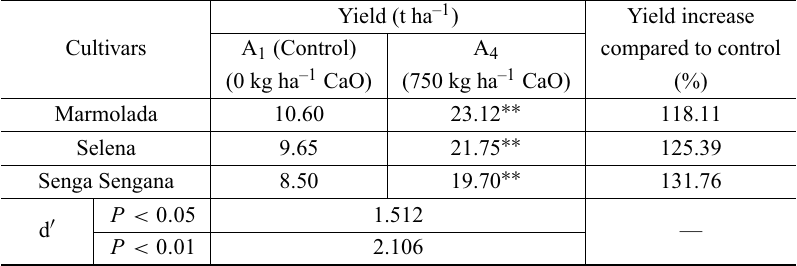
Yield of strawberry cultivars obtained in the control (A 1 ) without CaO application and in the A 4 treatment with 750 kg ha –1 CaO which resulted in the highest yield.